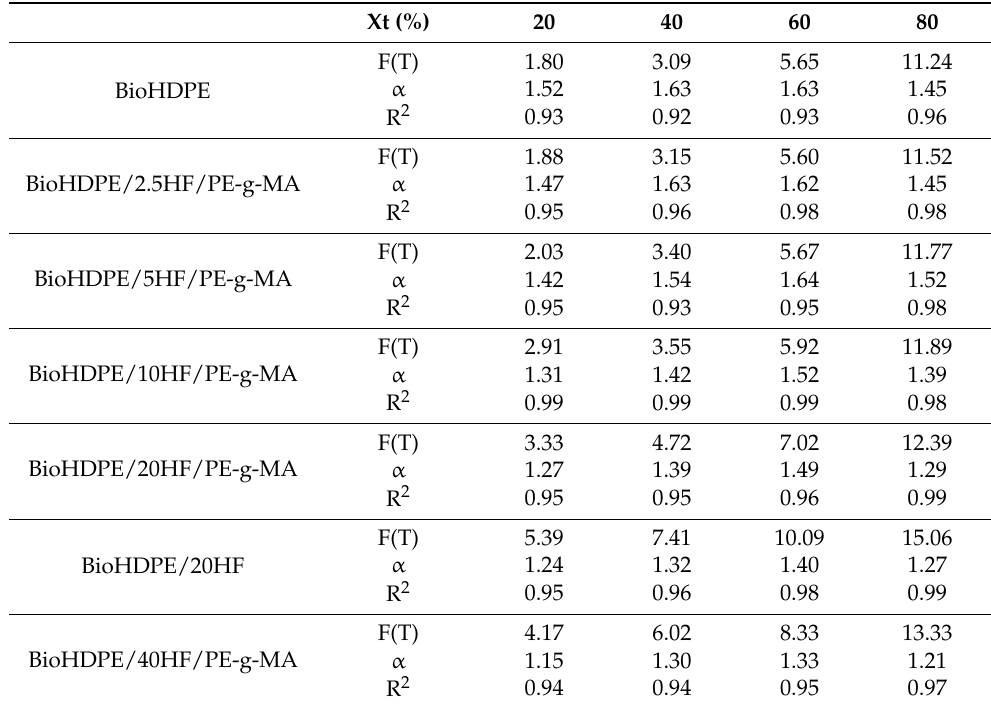
Table 4. Non-isothermal crystallization kinetic parameters of BioHDPE/Hemp composites obtained by the Avrami–Ozawa